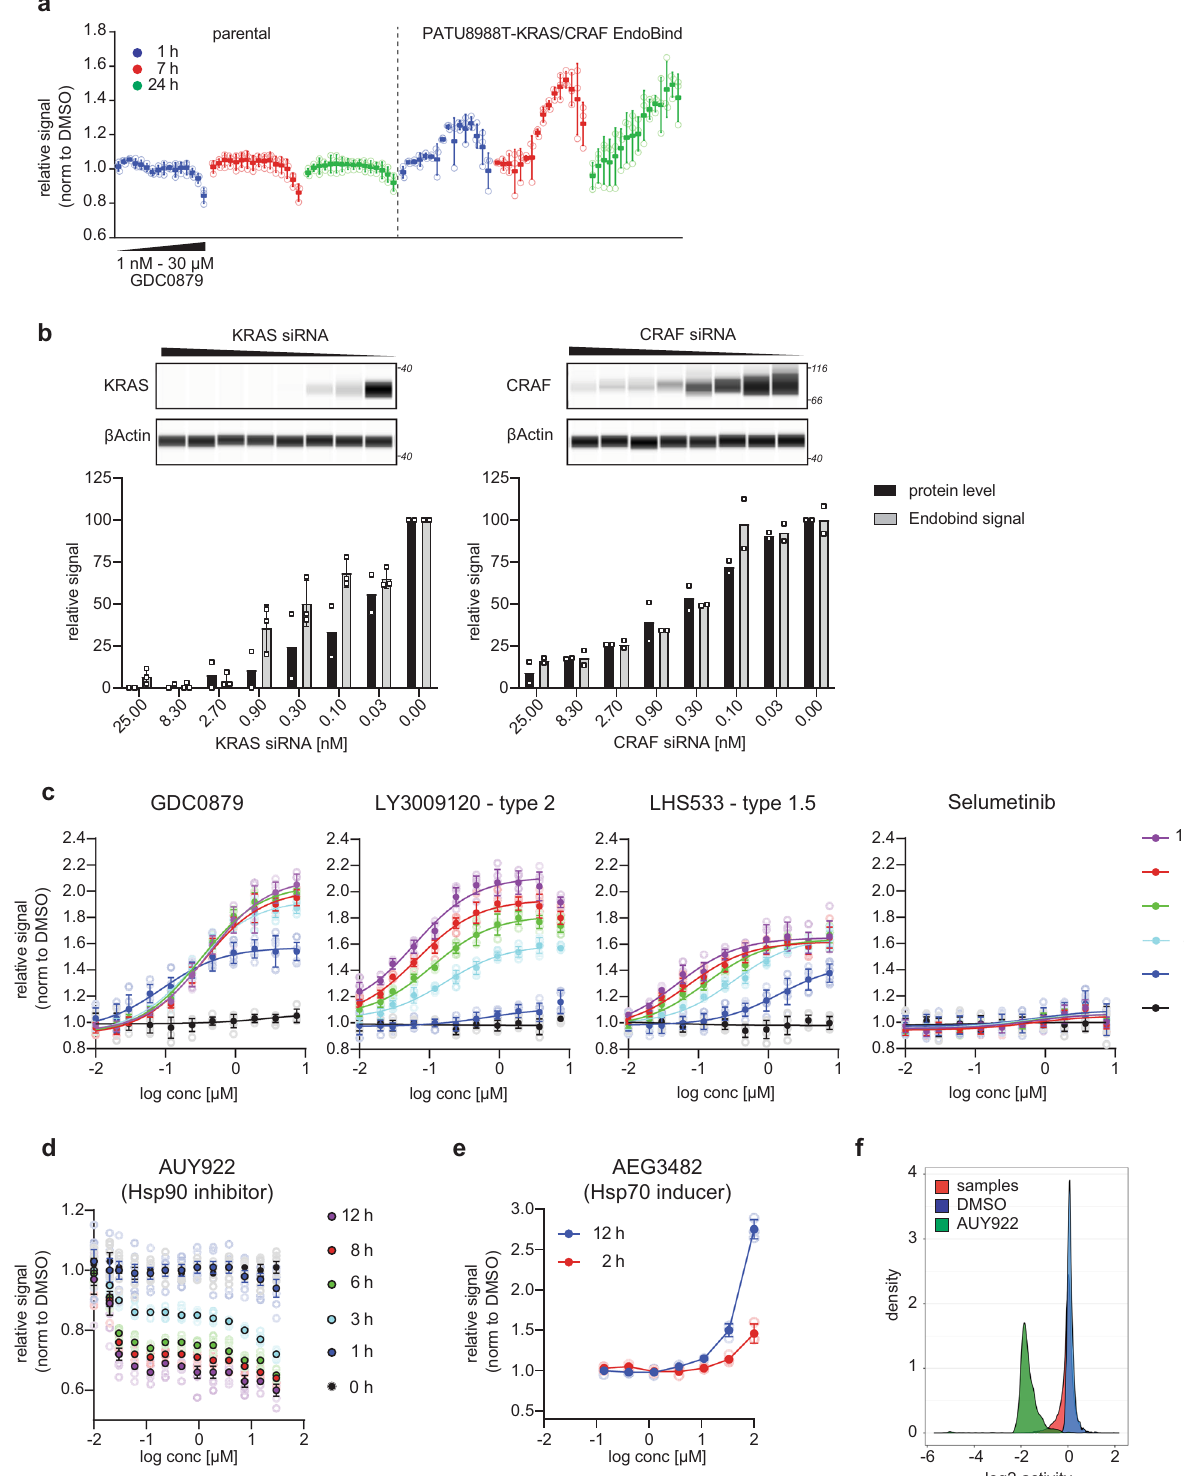
interaction after the indicated duration of treatment (Fig. 2c). The binding of RAF inhibitors to RAF in the presence of activated KRAS leads to allosteric priming, in which the RAF inhibitor promotes interaction of RAF with activated RAS by stabilizing the activated conformation of RAF 15 . According to this model, RAF inhibitors that bind to both protomers in a dimer (type 1 and type 2) show stronger allosteric priming than inhibitors of